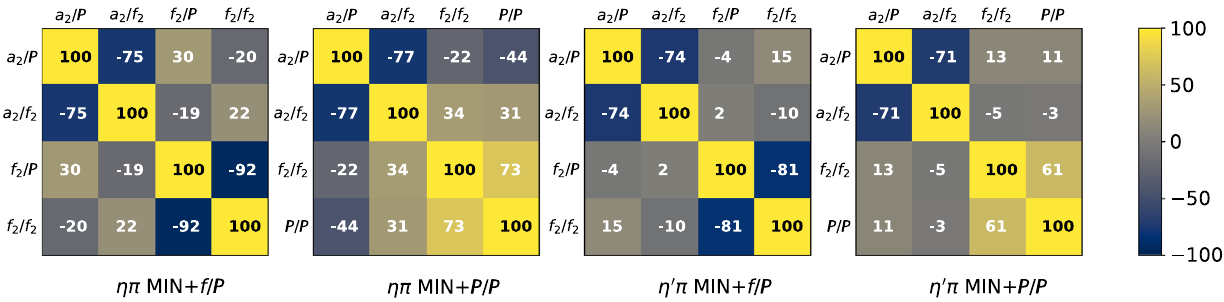
Fig. 29 Correlation plots for the fit parameters of the MIN + f / IP and MIN + IP / IP models for both ηπ and η (cid:2) π channels